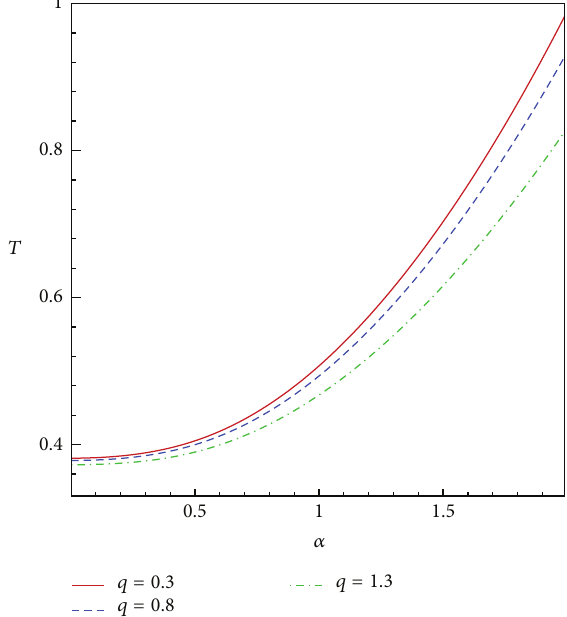
Figure 8: The behavior of 𝑇 versus 𝛼 with 𝑙 = 𝑏 = 1 , 𝑟 + = 1.5 , Ξ = 1.25 , 𝑛 = 5 , and 𝛽 = 2